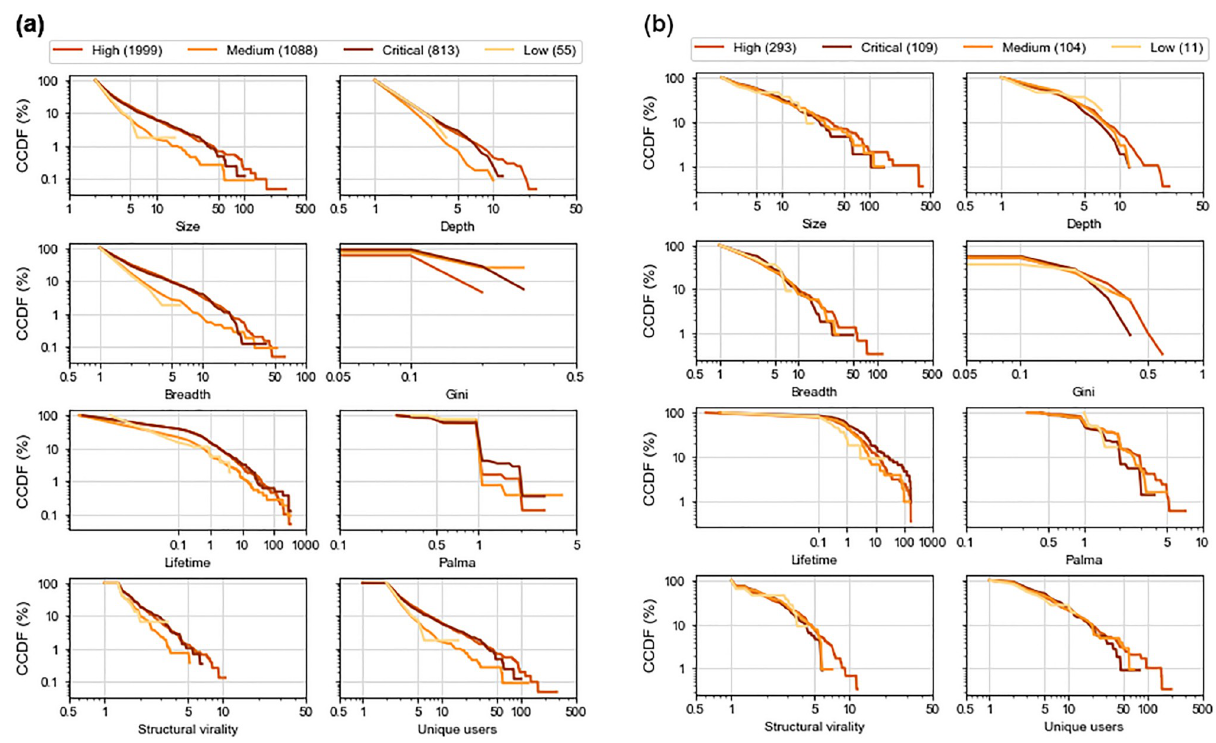
Fig 9. CCDF plots of information spread measurements of vulnerabilities with different severity on Reddit and Twitter. The numbers in parentheses are the number of discussion threads. Plots are shown in a log scale for both axes. (a) Twitter (b) Reddit.